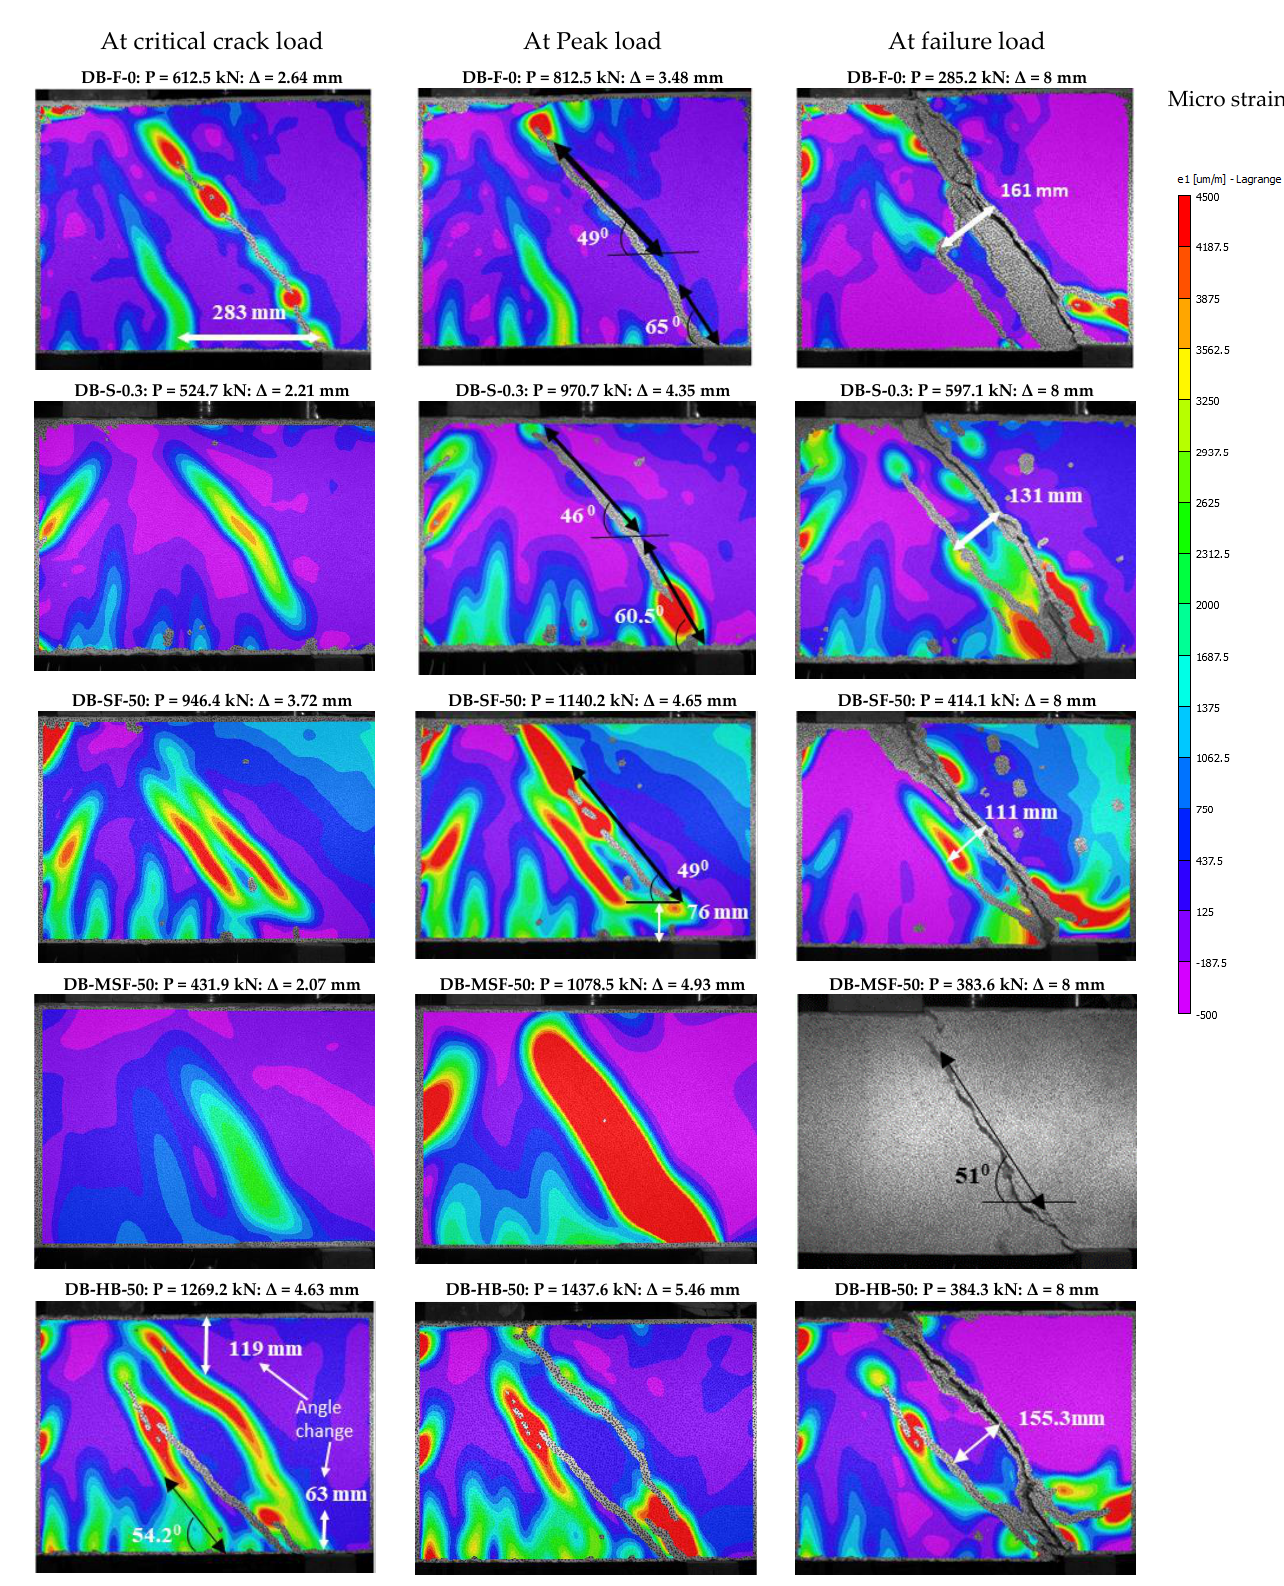
Figure 13. Principal strain contours of tested deep beams at key load points (+ve: tension, -ve: compression).